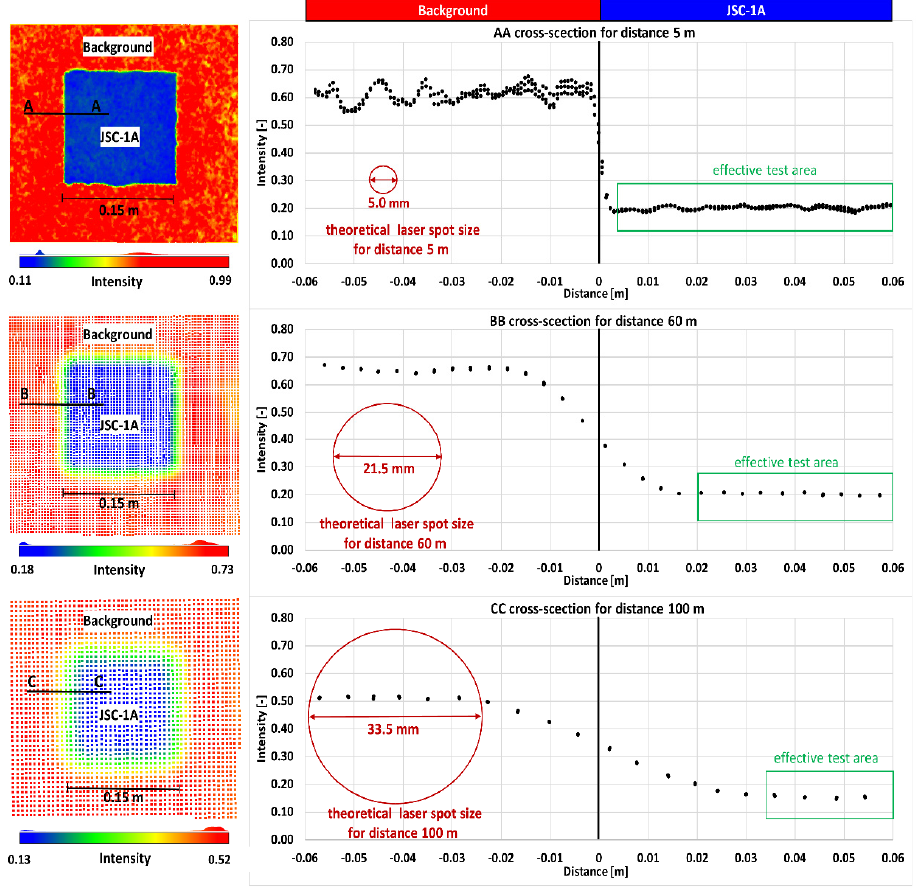
Figure 5. Effect of the spot size on the boundary measurement between two surfaces.